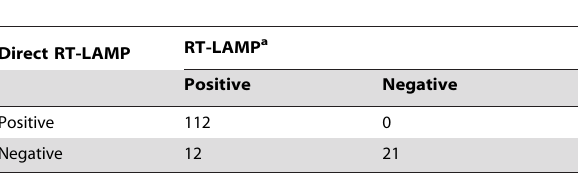
Table 1. Comparison of results of direct RT-LAMP assay with RT-LAMP assays obtained from 145 clinical nasopharyngeal swab